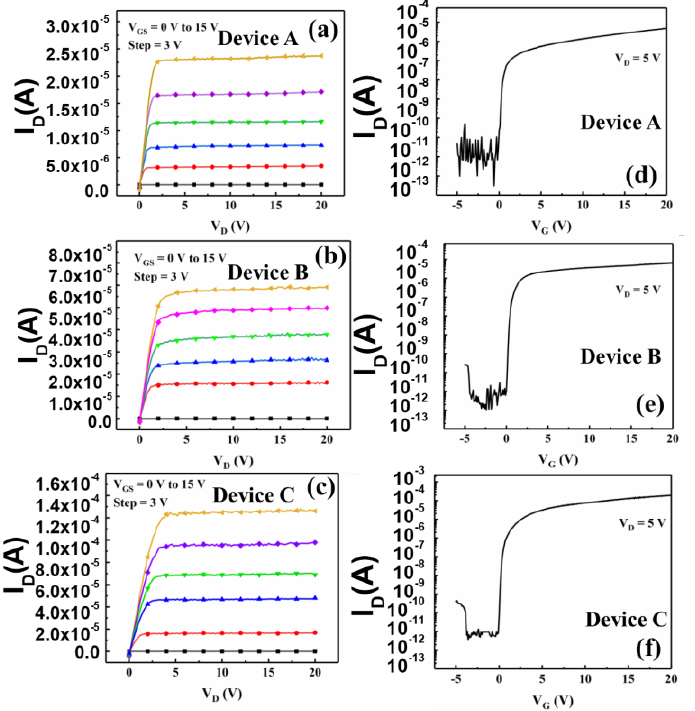
Figure 5. ( a – c ) Output curves and ( d – f ) transfer characteristics of device A, B, and C, respectively.